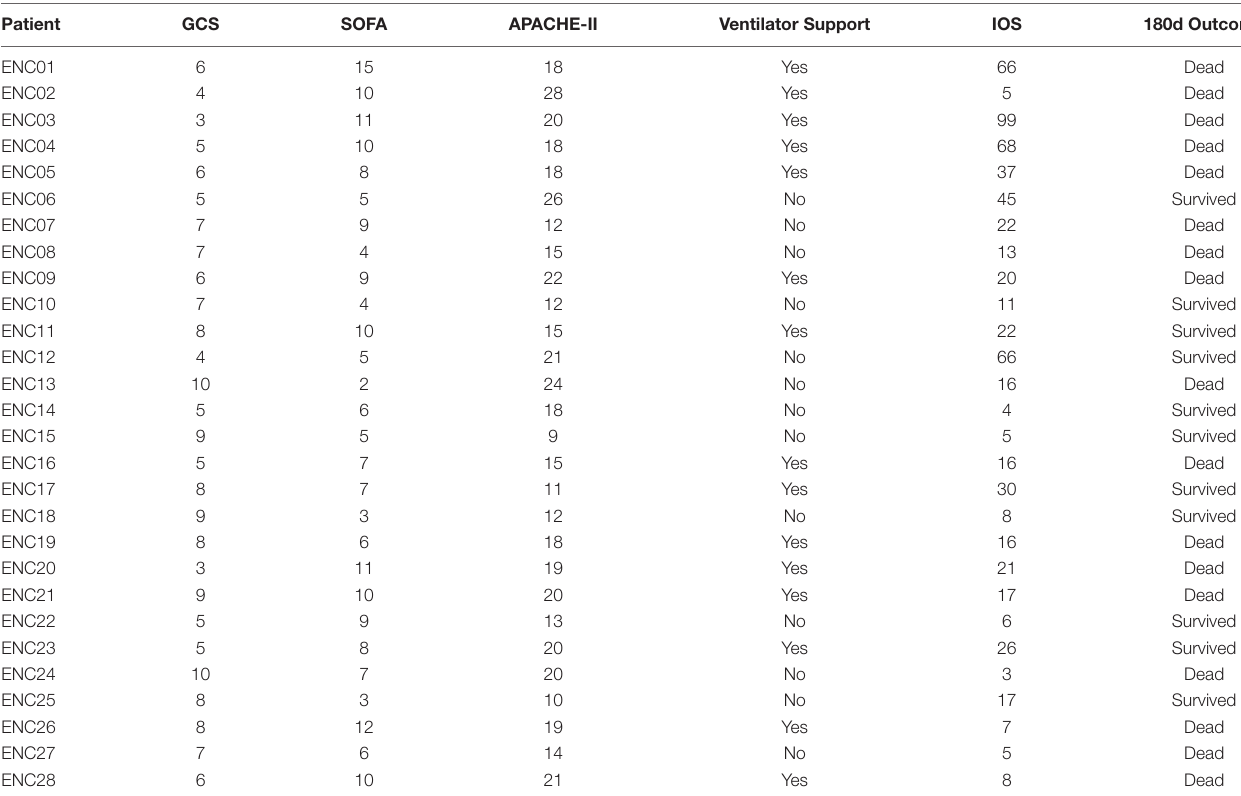
TABLE 1 | Clinical features obtained from 28 encephalitis